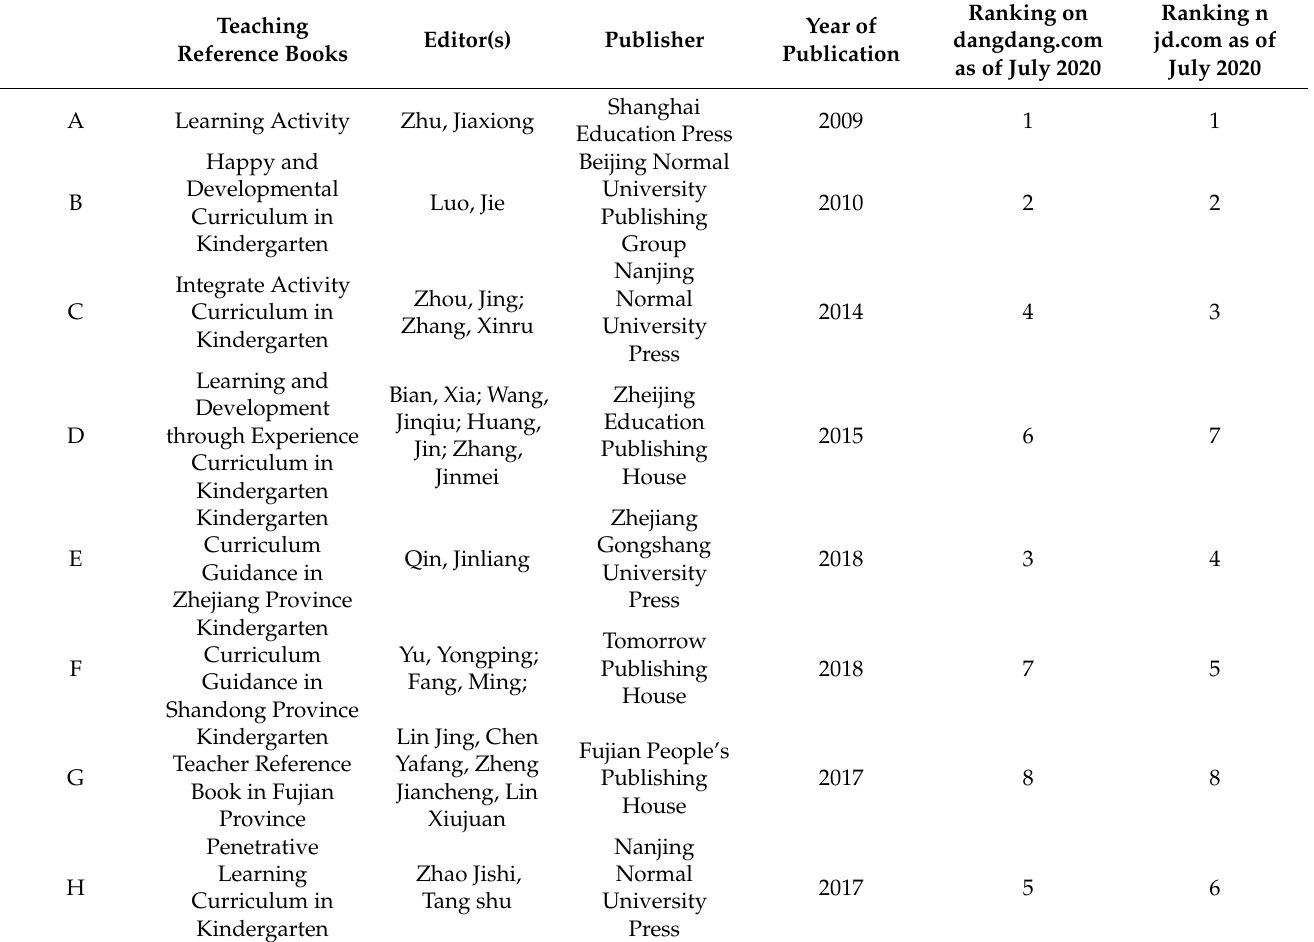
Table 1. Kindergarten teachers’ teaching reference books analyzed in this